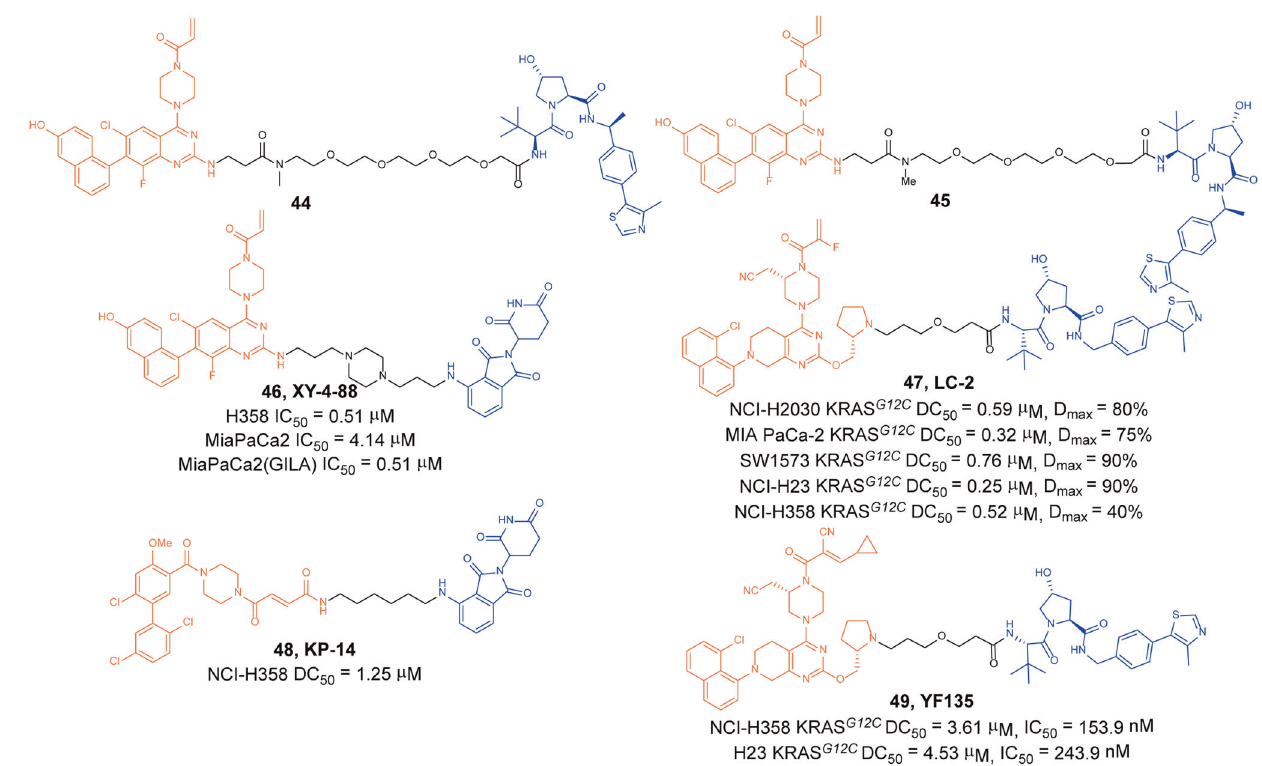
Fig. 12 The representative PROTACs targeting KRAS